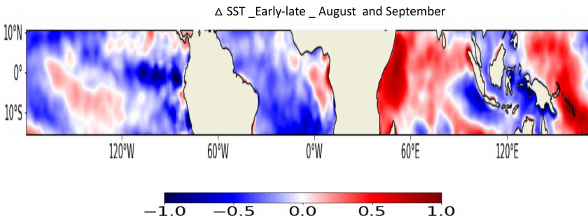
Figure 1. Map of mean of August and September δ SST for the time between the early- and late-onset